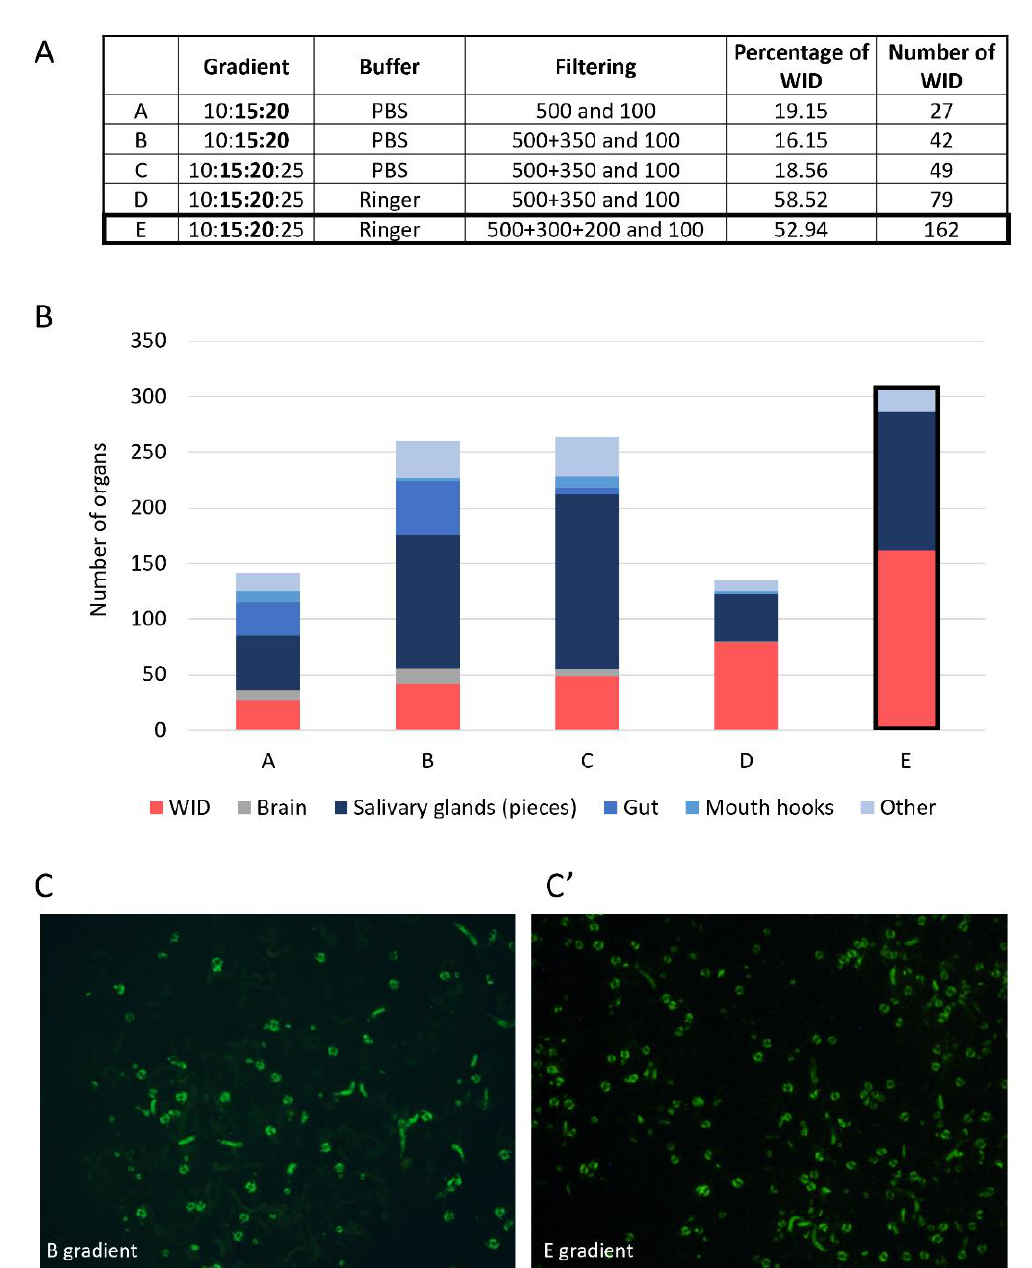
Figure 2. Overview of the improvement in the yield and purity during Ficoll gradient set-up. The “E” gradient is used in this protocol final version. ( A ) Table showing 5 examples of gradient configuration (Ficoll gradient in %, filtering in µ m (pore size)) and their outcome in proportion and number of wing imaginal discs (WID). Inputs were 5 mL of larvae. ( B ) Count of the different organs obtained in the output fractions. The “Other” group includes other imaginal discs (mainly legs and eye-antennae), proventriculus, and pieces of cuticles. ( C ) Examples of fractions obtained with the B ( C ) and E ( C’ ) gradients in GFP-exciting light, × 18. All pseudocircular GFP-marked objects are wing imaginal discs with vg -driven GFP expression.